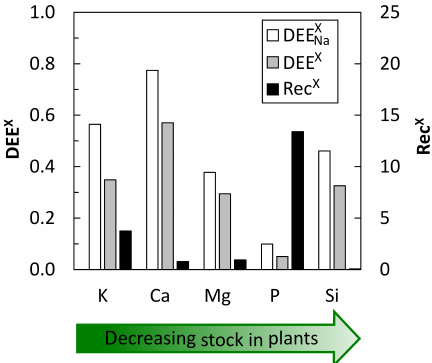
Figure 6. Dissolved export efficiency (DEE X , left y axis, Ta- ble S4d–e) and nutrient recycling factor (Rec X , right y axis, Ta- ble S4f) for macronutrients and the plant-beneficial element Si. The DEE X quantifies the dissolved riverine loss of X from the ecosys- tem relative to its net release from the regolith. DEE X refers to /W X the pure ratio W X (Eq. 12). DEE X refers to the ra- Na river regolith /W X tio W X normalised over its corresponding Na fluxes river regolith (Eq. 13). Rec X (Eq. 14) quantifies how often an element X is bio- utilised by plants after its release by chemical